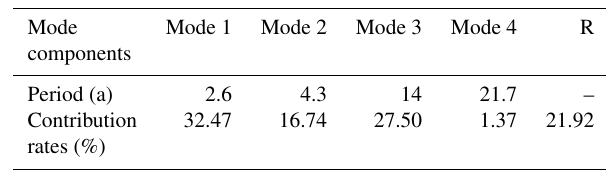
Table 1. Contribution rates of ESMD decomposition for mean pre- cipitation.